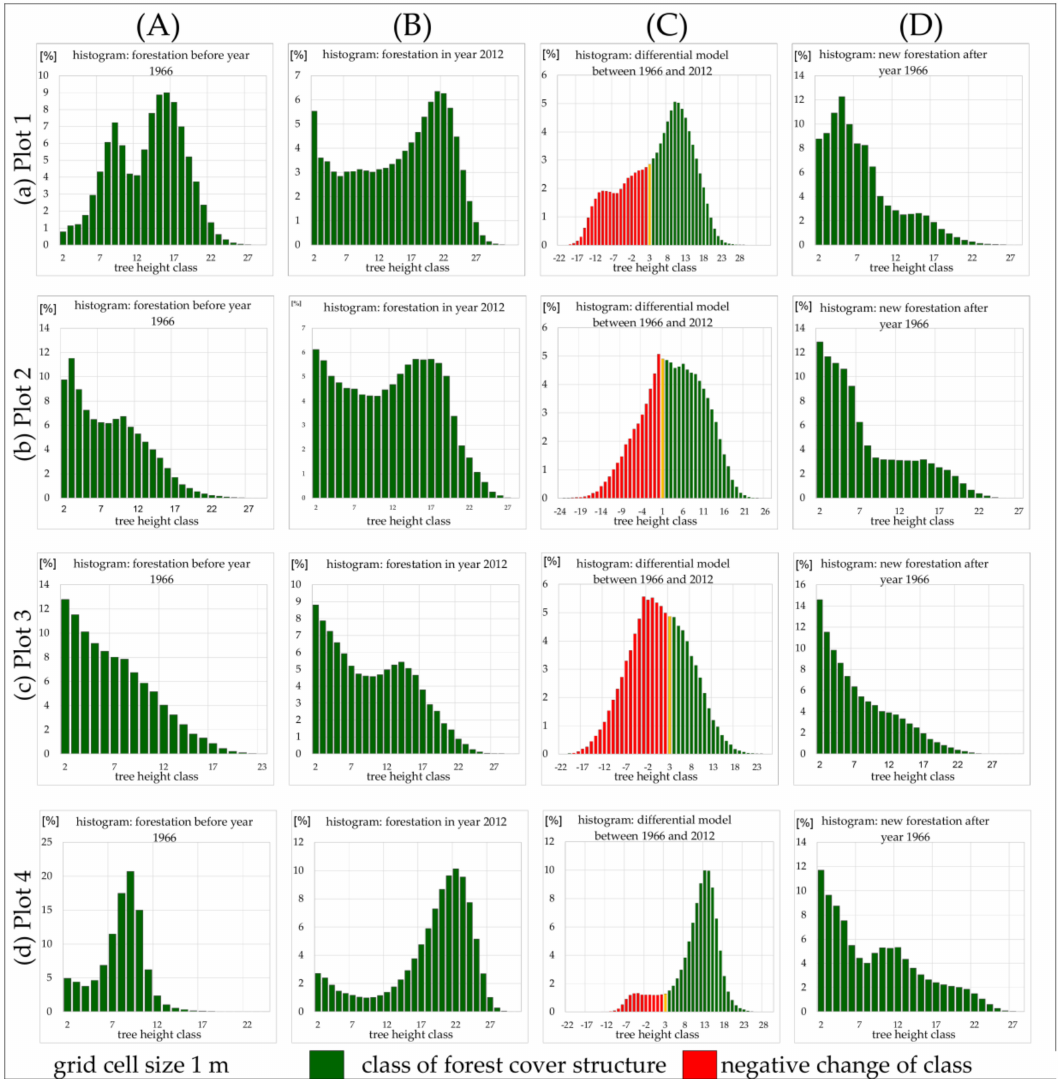
Figure 5. Histograms of a ff orestation height structure for plots developed with the use of grid cell size equal to 1